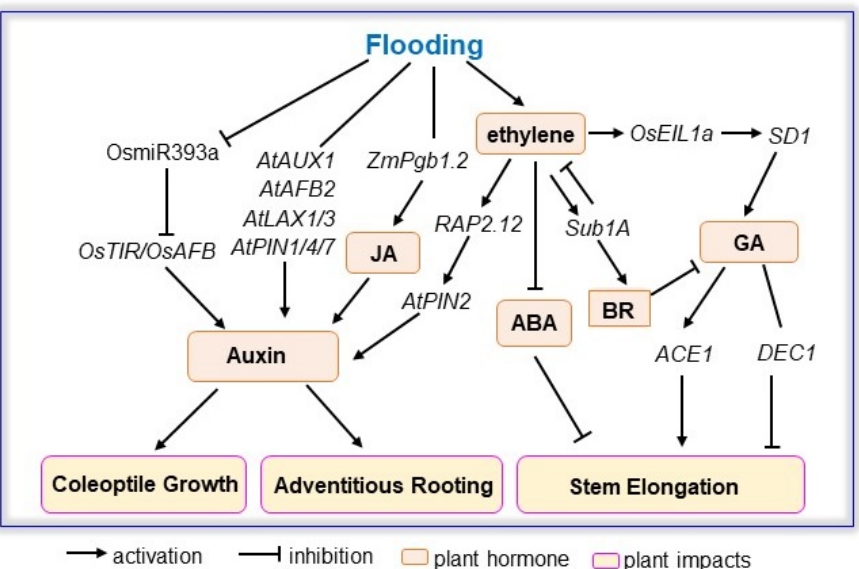
Figure 3. Interplays of GA, ABA, auxin, BR, ethylene, and JA signaling involved in plant response to flooding. The scheme of GA, ABA, auxin, BR, ethylene, and JA signaling associated with coleoptile growth, adventitious rooting, and stem elongation was constructed based on identified genes in Arabidopsis, rice, and maize. Flooding suppresses expression of miR393, which inhibits OsTIR and OsAFB , altering auxin mediated coleoptile growth during seed germination. Although auxin receptors and transports are affected differently by flooding, activation of PIN1/AUX1/AFB2 and suppression of LAX1/LAX3/PIN4/PIN7 improves adventitious rooting through auxin signaling. Meanwhile, gain-of-function of RAP2.12 activates AtPIN2 for auxin transport. The interaction between JA and auxin is evident in the enhancement of JA biosynthesis in plants overexpressing ZmPgb1.2 . Flooding induces expression of Sub1A and rice bearing Sub1A presented high amounts of BR, leading to a reduction in GA content. Furthermore, flood-induced ethylene activates OsEIL1a that binds to SD1 , leading to an increase in GA, which modulates stem elongation through ACE1 and DEC1. ABA, abscisic acid; ACE1, ACCELERATOR OF INTERNODE ELONGATION1 ; AFB, auxin signaling F-box; AUX, auxin resistant; BR, brassinosteroid; DEC1, DECELERATOR OF INTERNODE ELONGATION1; EIL1a, ethylene insensitive like1a; GA, gibberellic acid; JA, jasmonic acid; LAX, like AUX; Pgb, phytoglobin; PIN, plasma membrane intrinsic protein; RAP2.12 , related to apetala 2.12; SD1, SEMI-DWARF1; Sub1A, Submergence1A; TIR, transport inhibitor resistant Table 4. Effects of GA, auxin, BR, JA, and SA in plants during flooding stress. Hormones Plant Species Hormone Signaling Ref. duced internode elongation during the six ‐ leaf stage in deepwater rice. Rice